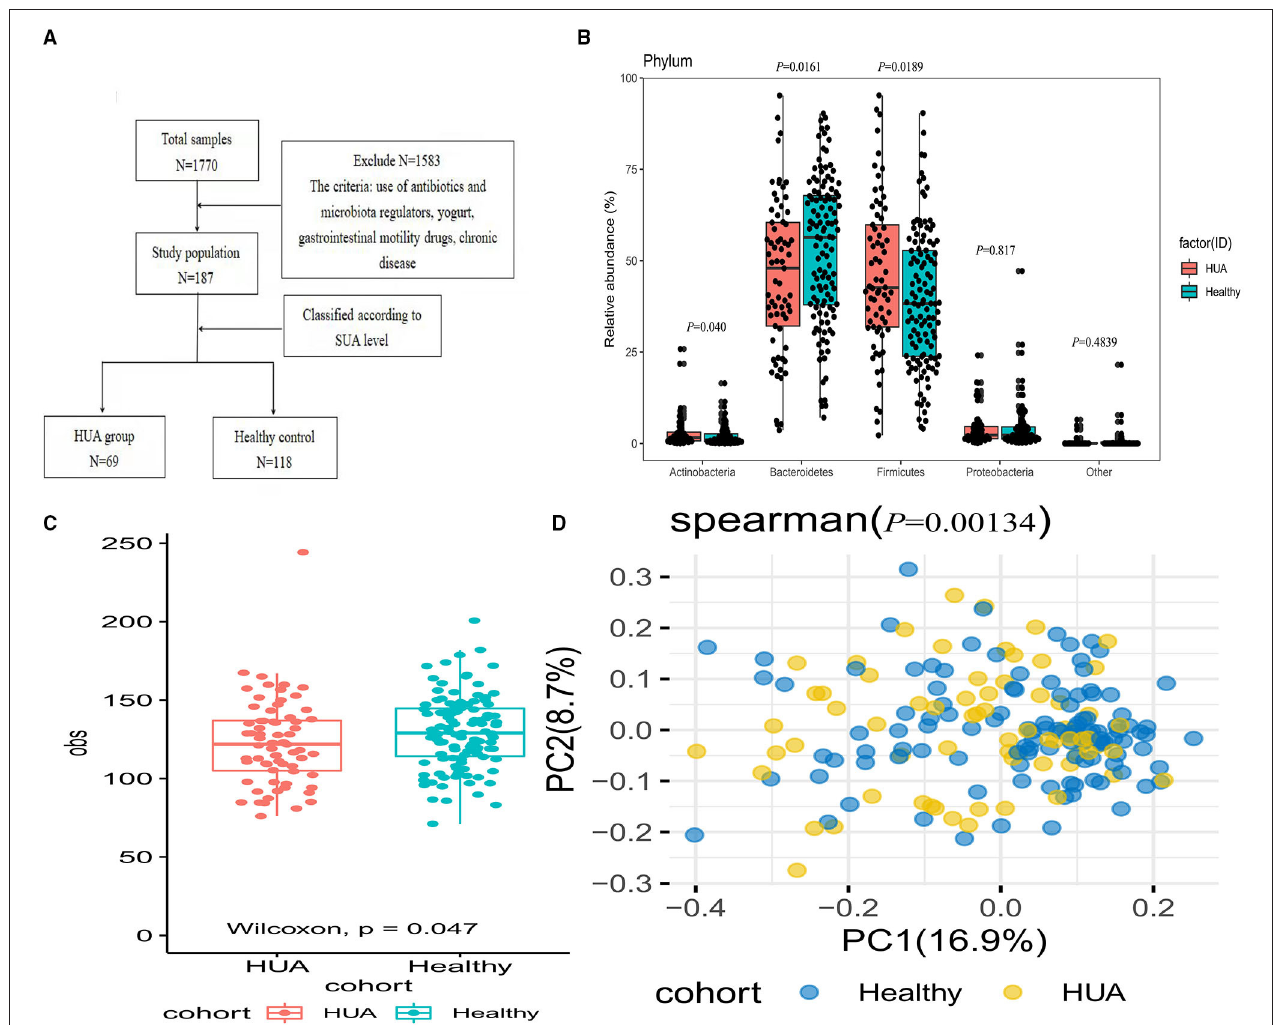
FIGURE 1 | Comparison of the microbial community between HUA group and healthy controls. (A) Enrollment flow; (B) The abundance of gut microbiota between HUA and healthy controls at the phylum level; (C) Alpha diversity was analyzed at the species level by obs index between HUA group ( N = 69) and healthy controls ( N = 118); (D) Beta diversity by Pearson distance between the two